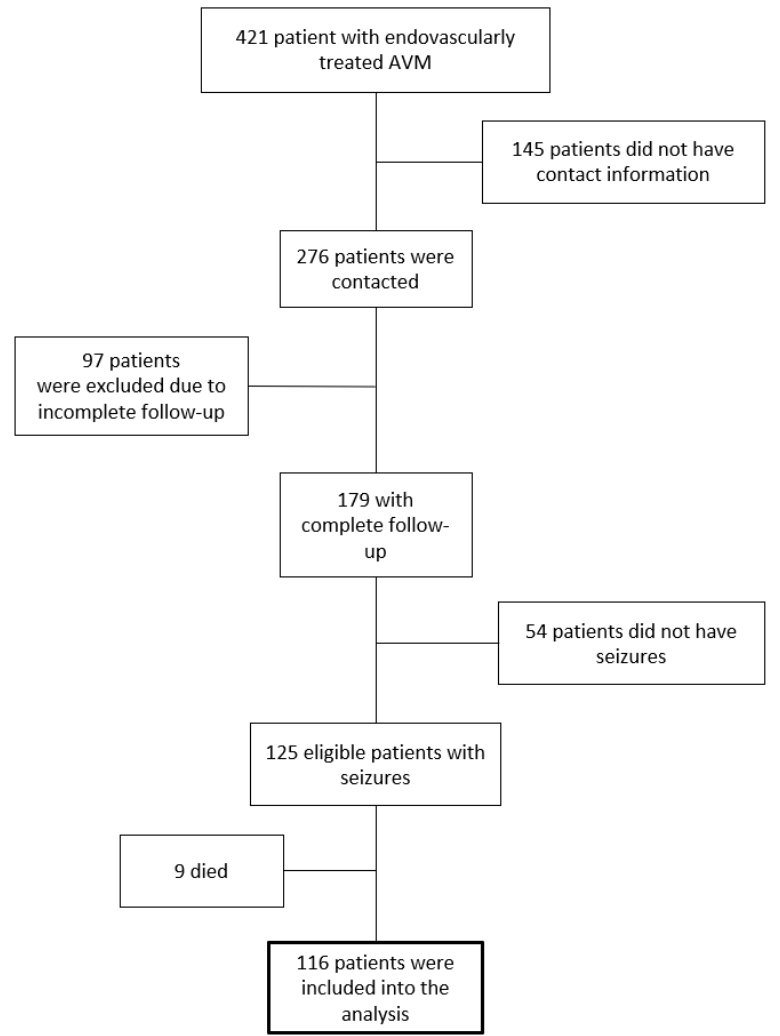
Figure 1. Patient exclusion and inclusion flow chart.